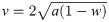
An example of a numerically-simulated monostable wave connecting E5 to E2 that is predicted for parameter range p>w+s, w<1, q+g<1.Specifically, a = 1, b = 1, s = 0.01, g = 0.15, w = 0.3, p = 1.1, q = 0.1. In particular, the values of s and g entail that the carrying capacity of farmers is 15 times that of hunter-gatherers [33]. Solid grey, broken black, and solid black curves give the normalized densities of initial farmers F, converted farmers C, and hunter-gatherers H, respectively, on the interval 0≤x≤800. It is worth noting that F and H are both below carrying capacity behind the wave front. The black arrow marks the wave front. The numerically estimated speed is 1.62, which is in good agreement with the heuristic minimum speed v=2a(1−w) = 1.67 (Appendix 3).